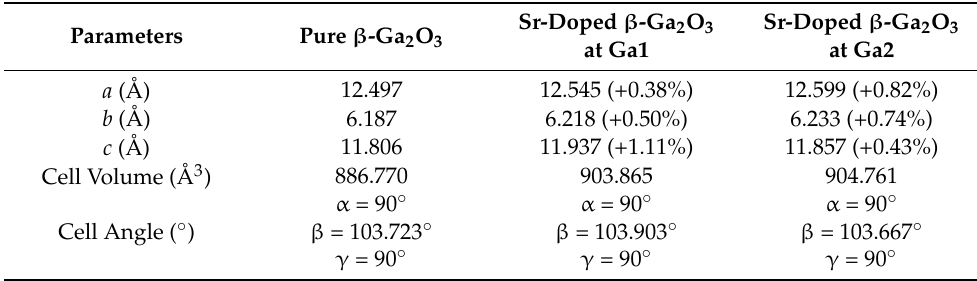
Table 2. Calculated lattice parameter ( a , b , and c ), cell volume, and cell angle of pure and Sr-doped